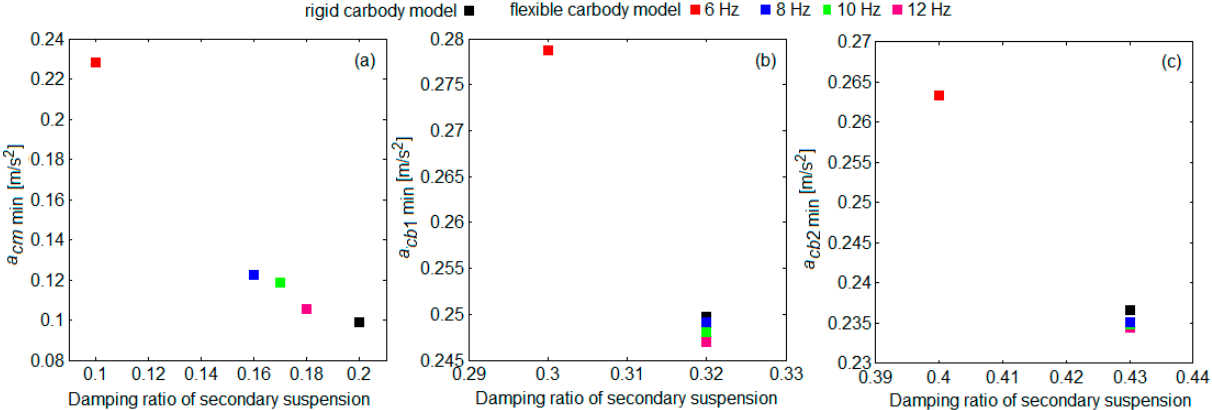
Figure 8. The damping ratio of secondary suspension minimizing the root mean square of acceleration: ( a ) at the carbody